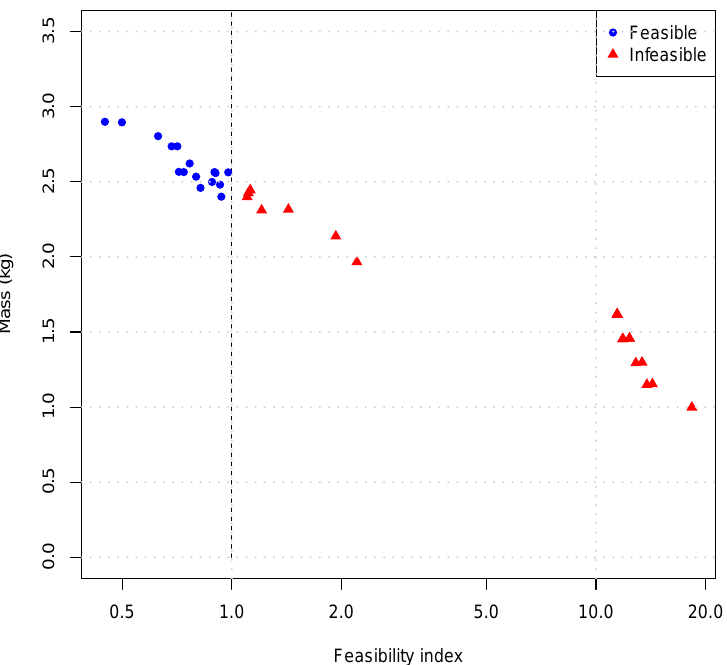
Figure 23. First DOE: Pareto front of the optimum mass for different feasibility indices with α = 0.5. The exploratory capabilities of the current optimization framework allow browsing amongst the feasible options. The designer can choose a target feasibility index based on minimum margins of safety, mass or other requirements. This capability is illustrated in the Pareto fronts of Figures 22 and 23. When there are no additional constraints, the feasible design that provides the minimum mass becomes a natural choice. Finally, the results of new FE evaluations can be added to the metamodel at any time to refine it in new or existing design